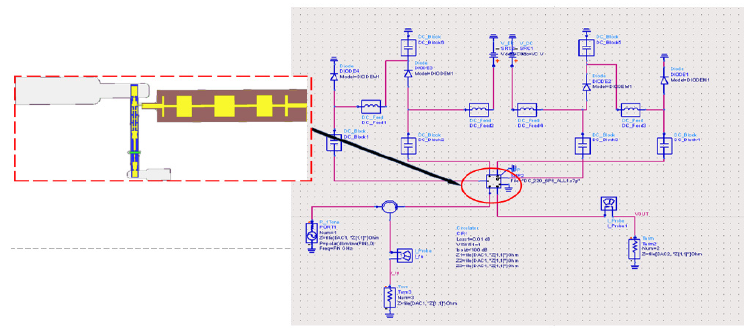
Figure 15. HFSS overall model and ADS overall circuit.